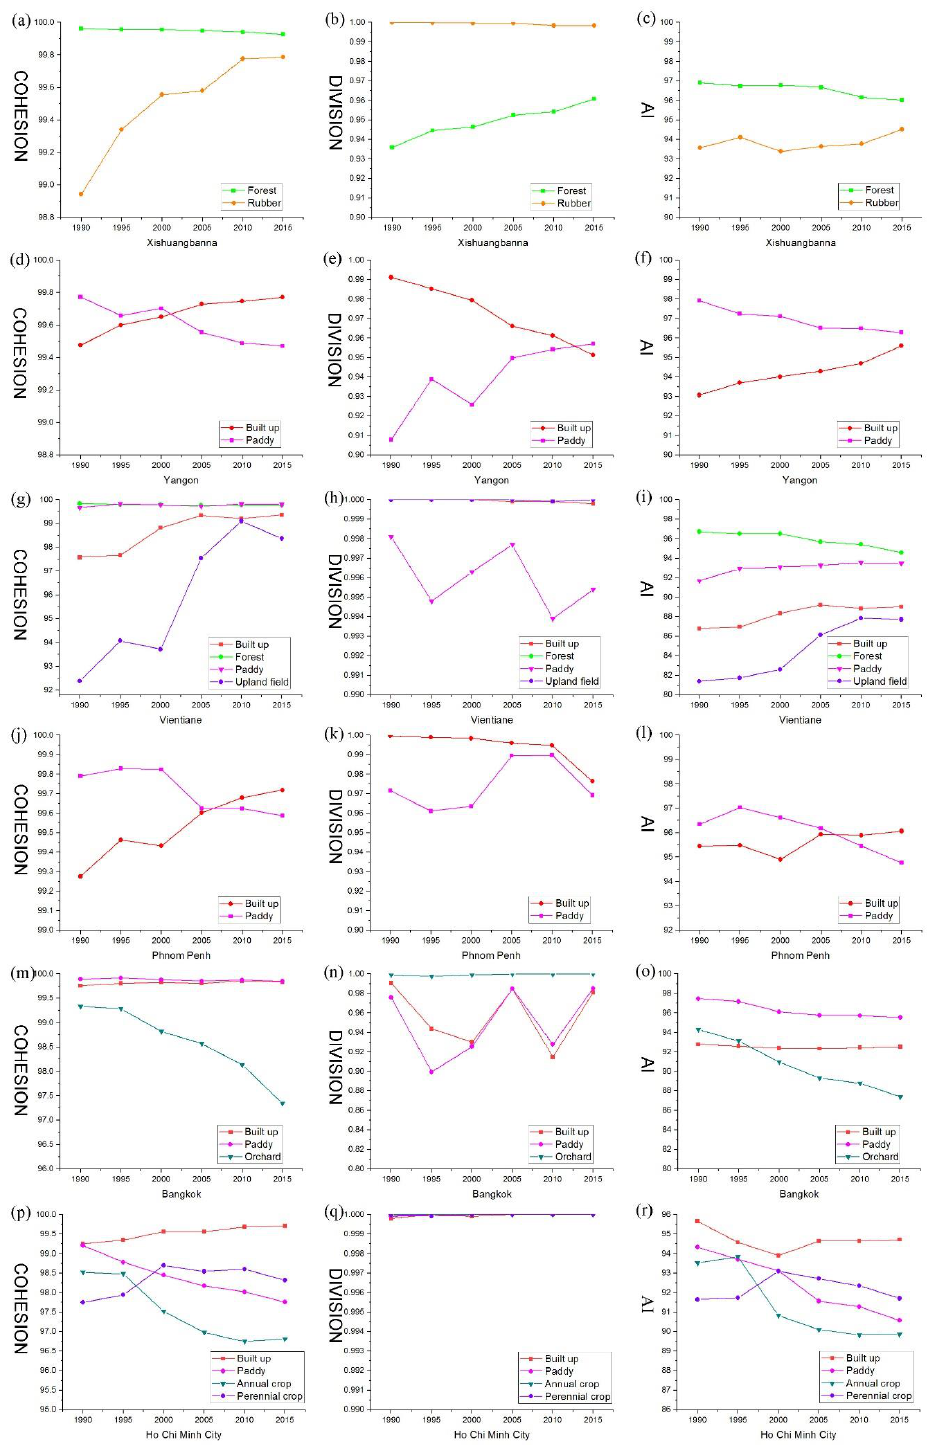
Figure 6. Landscape metrics (COHESION, DIVISION and AI) for six major cities in GMS. ( a ) represents COHESION of Xishuangbanna, ( b ) represents DIVISION of Xishuangbanna, ( c ) represents AI of Xishuangbanna, ( d ) represents COHESION of Yangon, ( e ) represents DIVISION of Yangon, ( f ) represents AI of Yangon, ( g ) represents COHESION of Vientiane, ( h ) represents DIVISION of Vientiane, ( i ) represents AI of Vientiane, ( j ) represents COHESION of Phnom Penh, ( k ) represents DIVISION of Phnom Penh, ( l ) represents AI of Phnom Penh, ( m ) represents COHESION of Bangkok, ( n ) represents DIVISION of Bangkok, ( o ) represents AI of Bangkok, ( p ) represents COHESION of Ho Chi Minh City, ( q ) represents DIVISION of Ho Chi Minh City, ( r ) represents AI of Ho Chi Minh